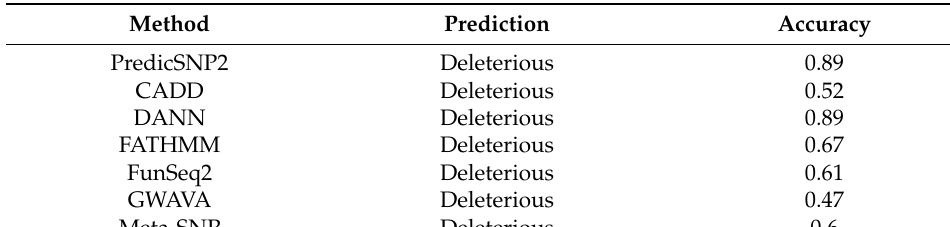
Table 2. In silico predictions of protein stability upon single amino acid change using sequence-based tools. Reference human POR sequence NCBI: NP_000932.3.